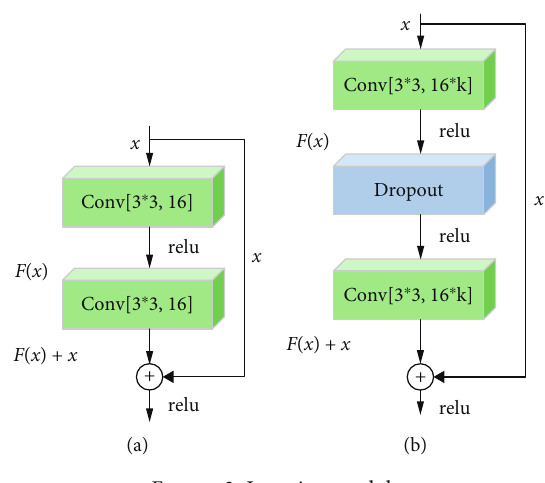
Figure 3: Learning